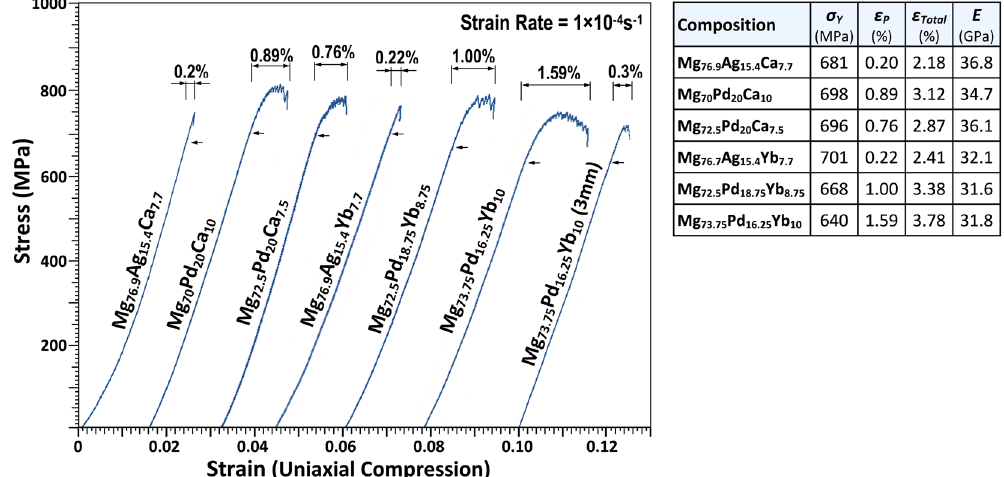
Figure 6. Uniaxial compression curves and associated data for yield strength ( σ y ), plastic strain ( ε P ), total strain to failure ( ε Total ) and Young’s modulus (E) for selected Mg–[Ag,Pd]–[Ca,Yb] BMGs deformed at a strain rate of 1 × 10 − 4 s − 1 . The sample diameters were 1.7 mm (height-to diameter ratio 2:1) with the exception of the Mg 73.75 Pd 16.25 Yb 10 BMG, which was also tested with a diameter of 3